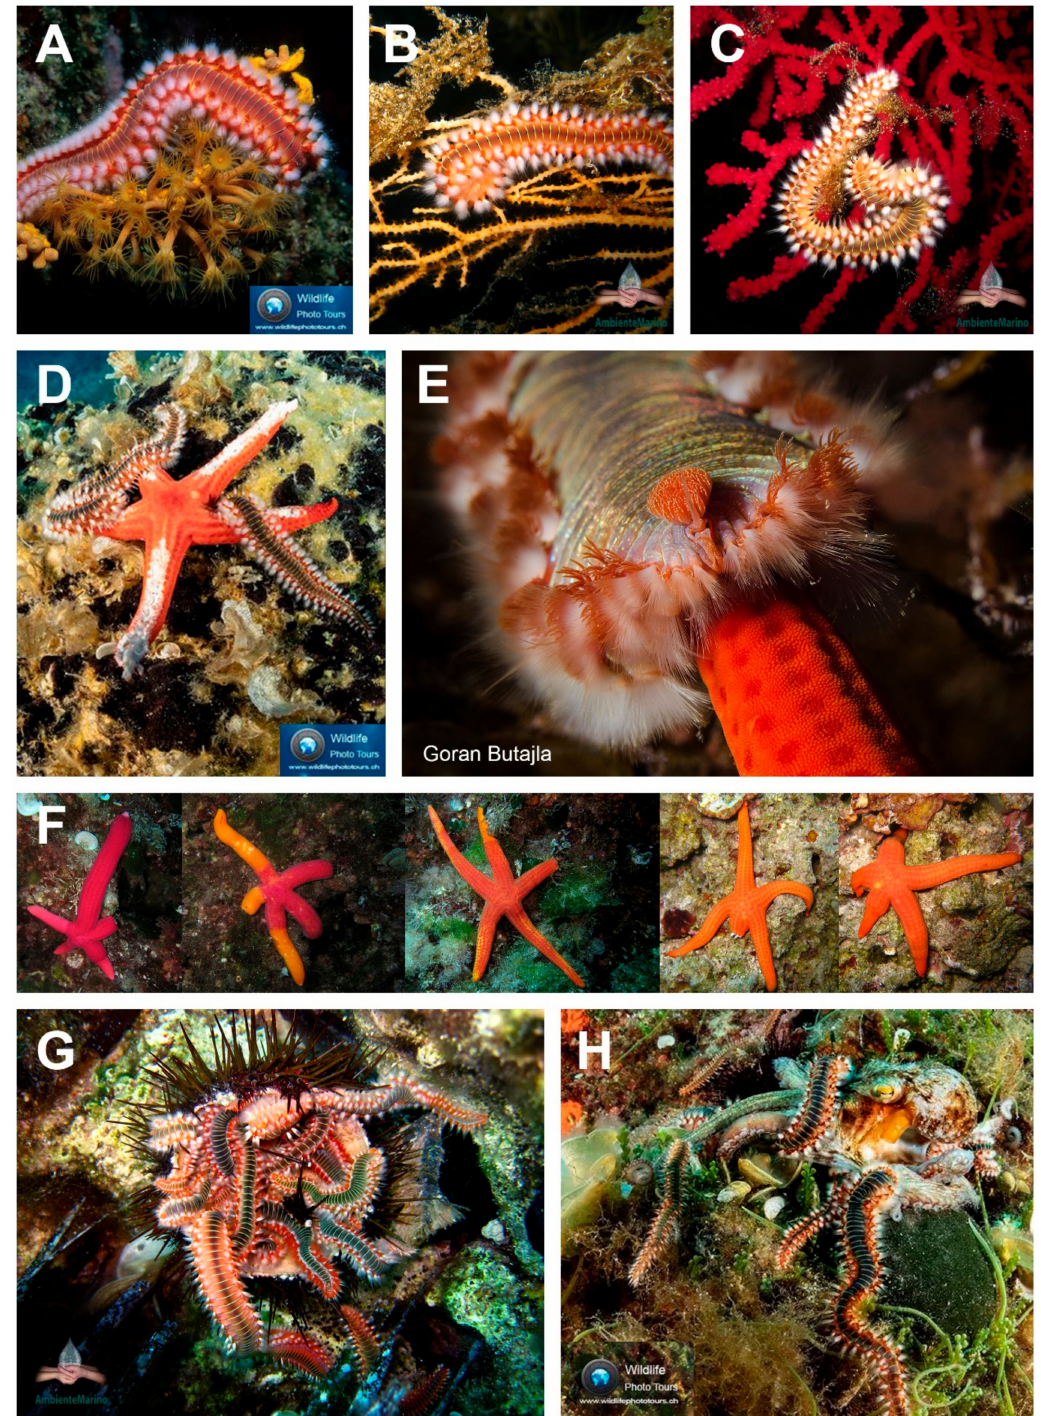
Figure 7. Feeding behavior of Hermodice carunculata from Croatian waters, underwater photos. ( A – C ). Fireworms feeding on ( A ) the zoanthid Parazoanthus axinellae and ( B ) the gorgonians Eunicella cavolini and ( C ) Paramuricea clavata ; ( D ) starfish ( Hacelia attenuata ) attacked by fireworms. Note longitudinal white scares along the starfish arms due to bites of the fireworms; ( E ) detail of a worm biting an arm of H. attenuata ; ( F ) several specimens of Ophidiaster ophidianus (first two pics) and Hacelia attenuata probably injured by fireworms. Note maimed arms, discolored areas, scars; Mass attack of fireworms on ( G ) the sea urchin Paracentrotus lividus and on a ( H ) young specimen of Octopus vulgaris